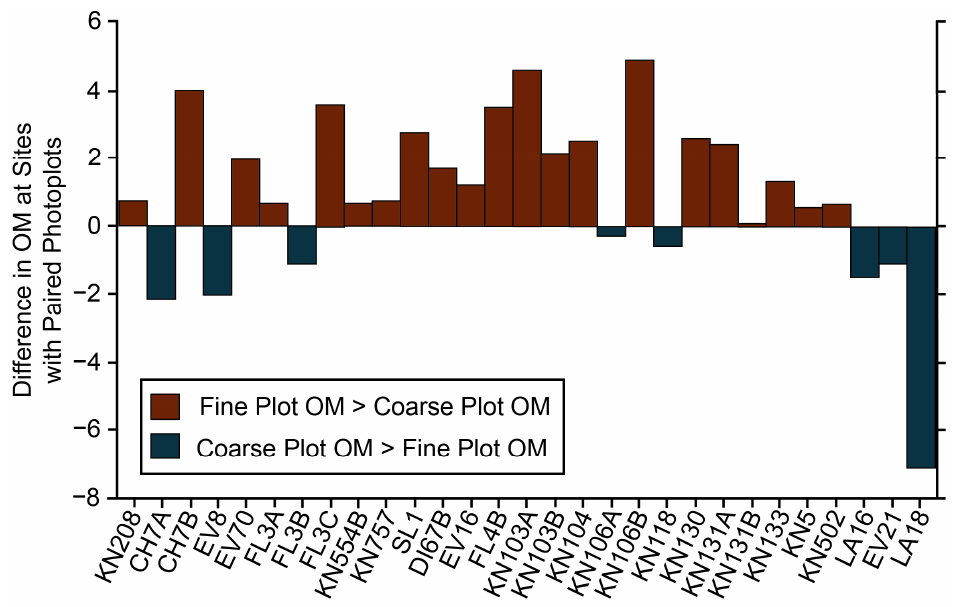
Figure 8. Results of Validation Test #2: comparison of OM values for beaches with observed along- shore heterogeneity in grain size, for which both fine and coarse plots were sampled. Table 4. Summary of results of Validation Test #2: differences in abar and OM between plots with relatively coarse and relatively fine clasts. Only sites where two plots at the same beach were sam- pled were included in analyses.